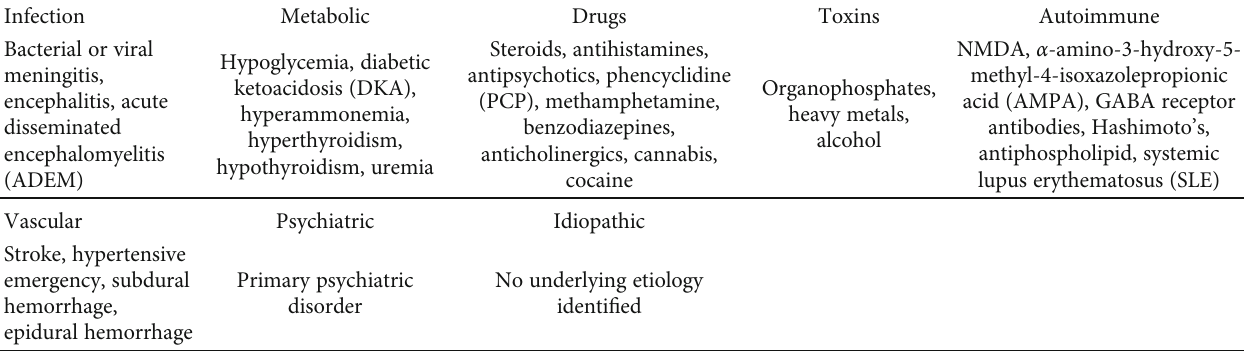
Table 1: Di ff erential diagnosis for CANS.